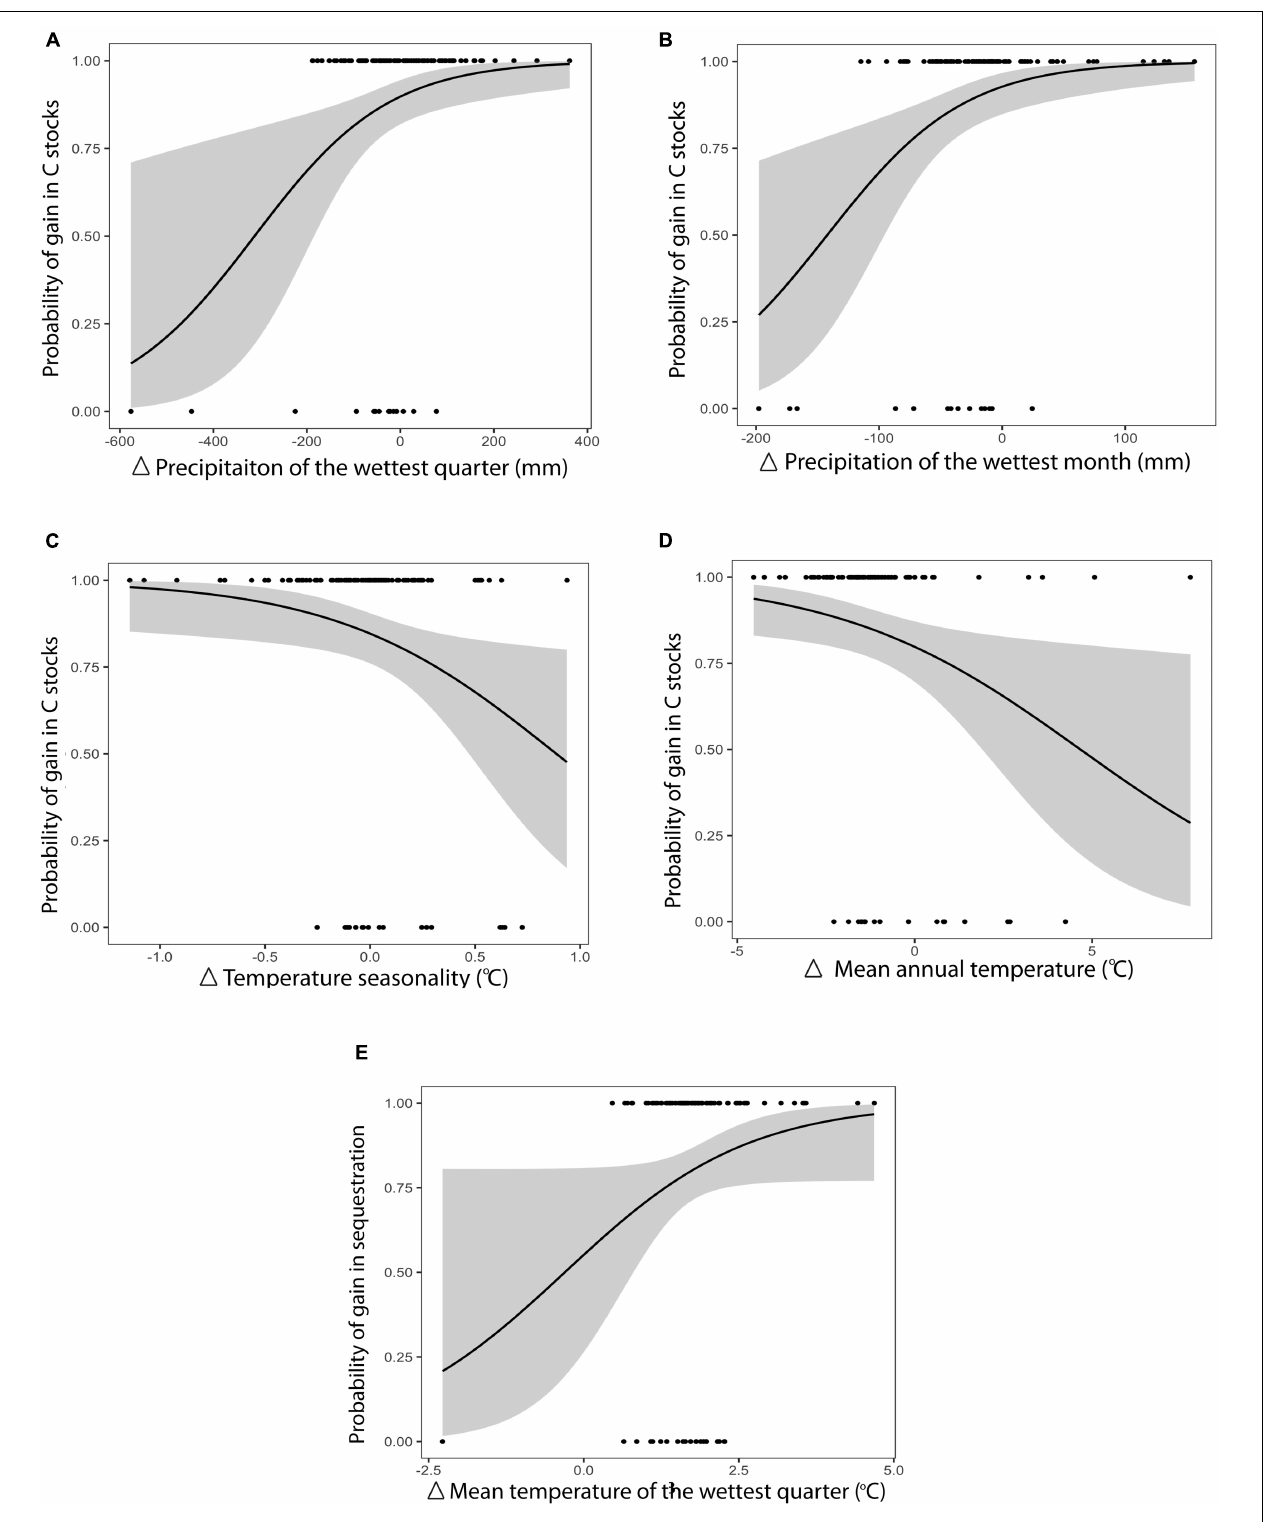
FIGURE 2 | Probability of countries experiencing gains in mangrove C stocks with change in twenty-first century climate. (A,B) Refer to significant differences under the “business as usual” scenario (SSP245), (C,D) refer to significant differences under the high emissions scenario (SSP585) and (E) refers to sequestration rates. Temperature seasonality refers to the annual variation of temperature. Black lines are the mean probability, while shaded areas represent 95% confidence intervals.